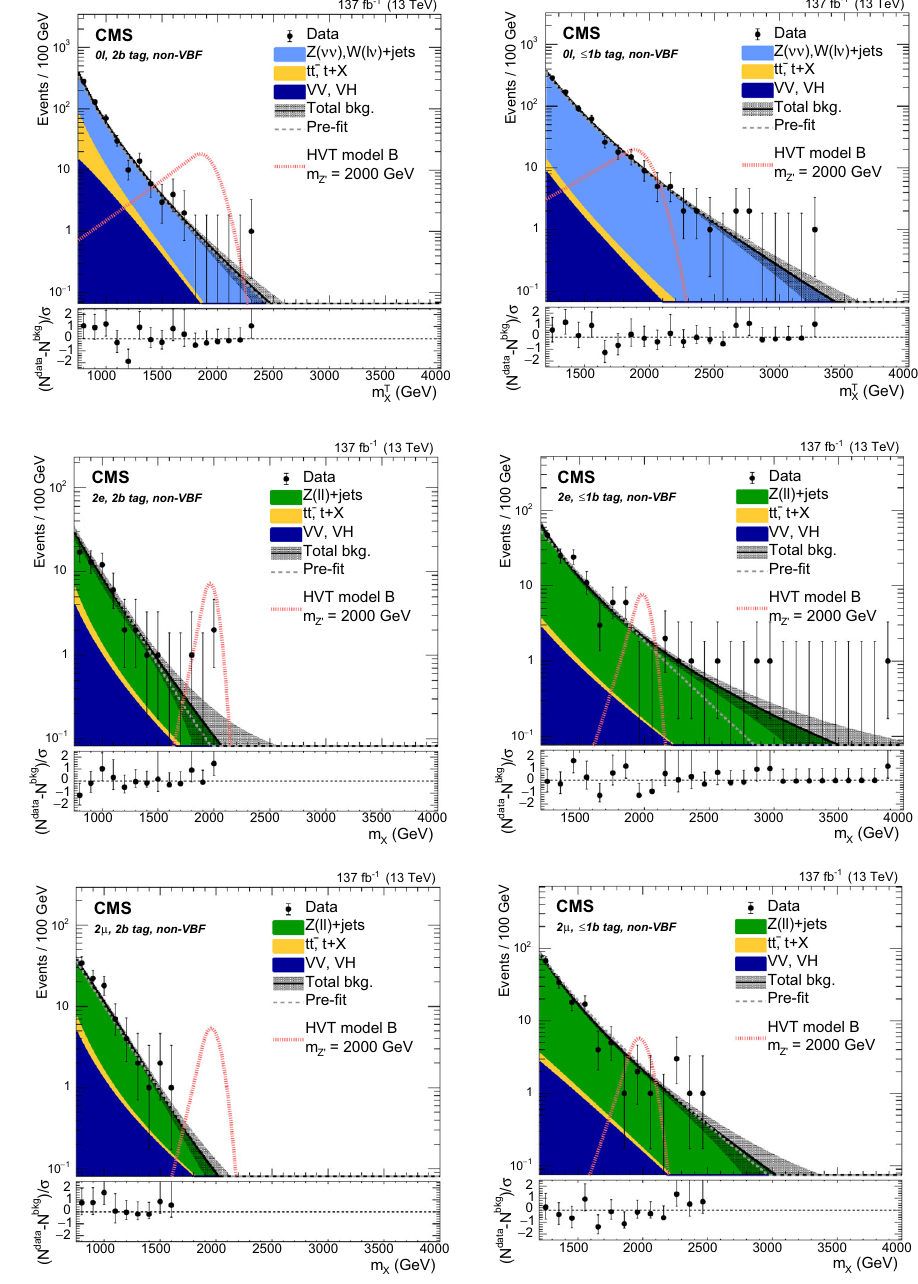
Fig. 5 Distributions in data in the 2b tag (left column) and ≤ 1b tag (right column) non-VBF categories, of m T for X 0 (cid:4) (upper row), and m X for 2e (middle row), and 2 μ (lower row). The distributions are shown up to 4000GeV, which corresponds to the event with the highest m X or m T observed X in the SR. The shaded bands represent the uncertainty from the background estimation. The observed data are represented by black markers, and the potential contribution of a resonance produced in the context of the HVT model B at m Z (cid:3) = 2000GeV is shown as a dotted red line. The bottom panel shows ( N data − N bkg )/σ for each bin, where σ is the statistical uncertainty in